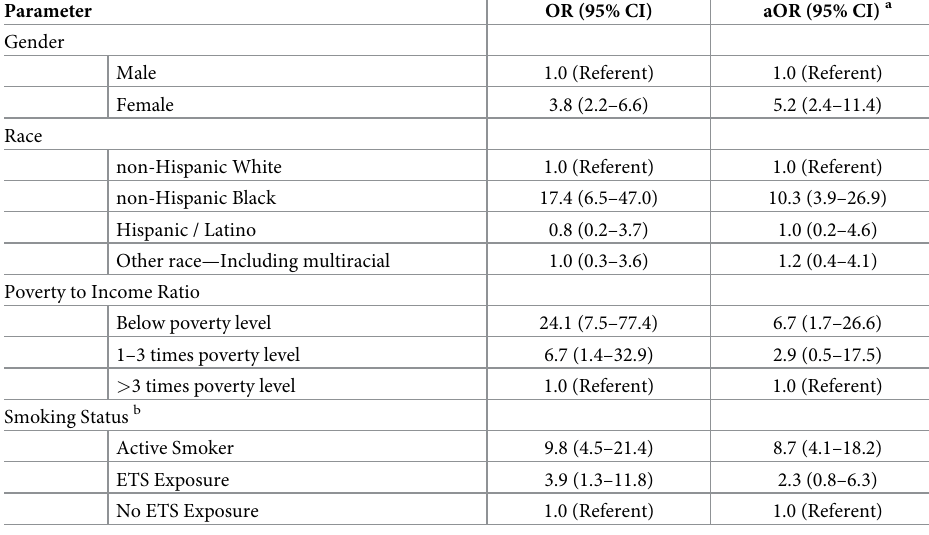
Table 3. Unadjusted and adjusted odds ratios: Trichomonas infection risk factors, n =